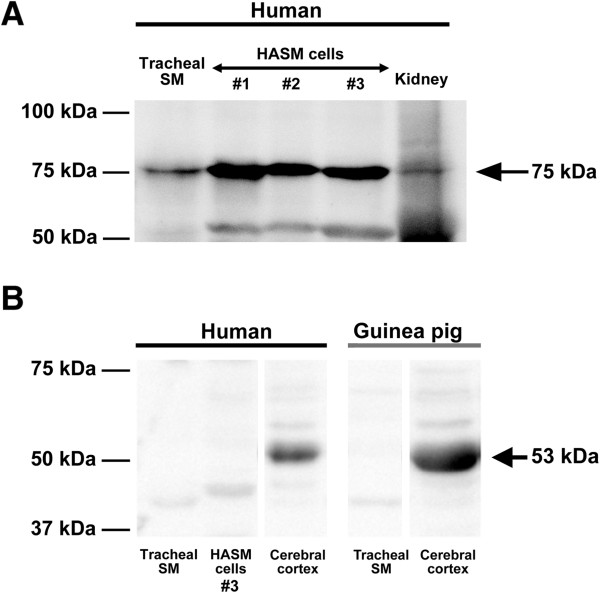
Immunoblot analysis of dopamine D1-like receptors in human and guinea pig airway smooth muscle. Representative immunoblot analyses using antibodies against the dopamine D1 receptor (A) and D5 receptor (B) using 100 μg total protein prepared from freshly dissected native human tracheal airway smooth muscle (SM), cultured HASM cells from all three different sources [#1: cultures of immortalized HASM cells gifted from Dr. William Gerthoffer, #2: primary cultured cells gifted from Dr. Reynold A. Panettieri, Jr., and #3: primary cultured cells obtained from Lonza (Walkersville, MD)], freshly dissected native guinea pig tracheal SM, human kidney, and human or guinea pig brain cerebral cortex. White spaces between the lanes in (B) indicate that these lanes were located on the same immunoblot but were not located in neighboring lanes on the original gel and immunoblot image.